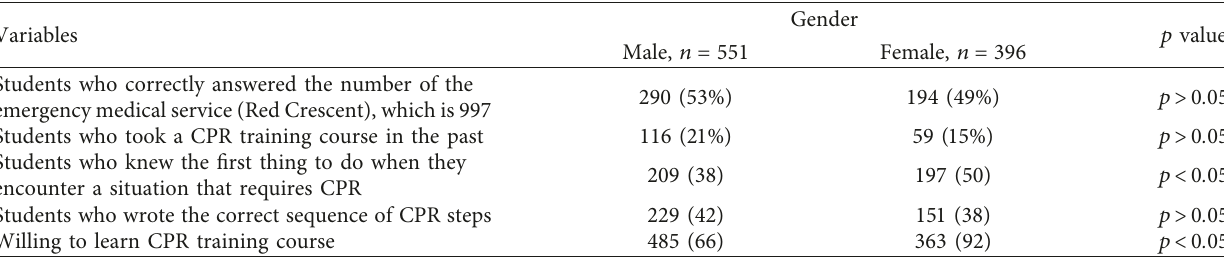
Figure 5: The effective method in students’ opinion to increase public awareness about CPR. Table 7: Comparison between both